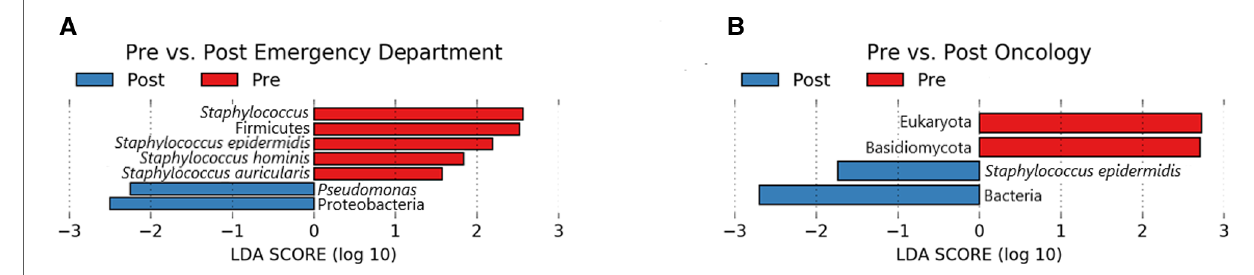
FIGURE 5 Lefse pre/post for emergency department ( A ) and oncology ward ( B ). Taxa that were enriched in Pre/baseline are indicated with red bars, while taxa that were enriched in the post-intervention samples are indicated with blue bars. Signi fi cant (Kruskal-Wallis, p ≤ 0.05 and log (LDA) ≥ 1.5) features are